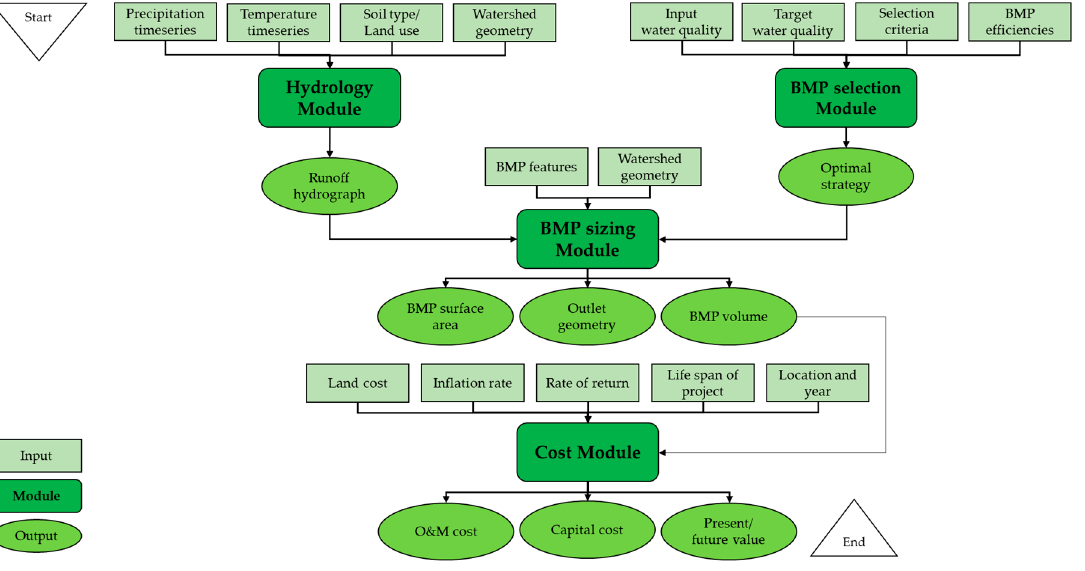
Figure A2. i-DSTss Introductory page